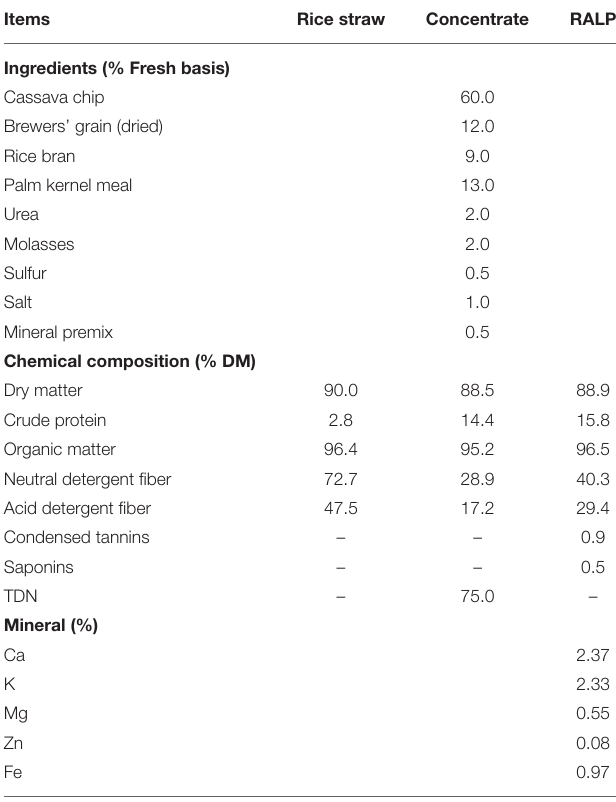
TABLE 1 | Feed ingredients and their chemical